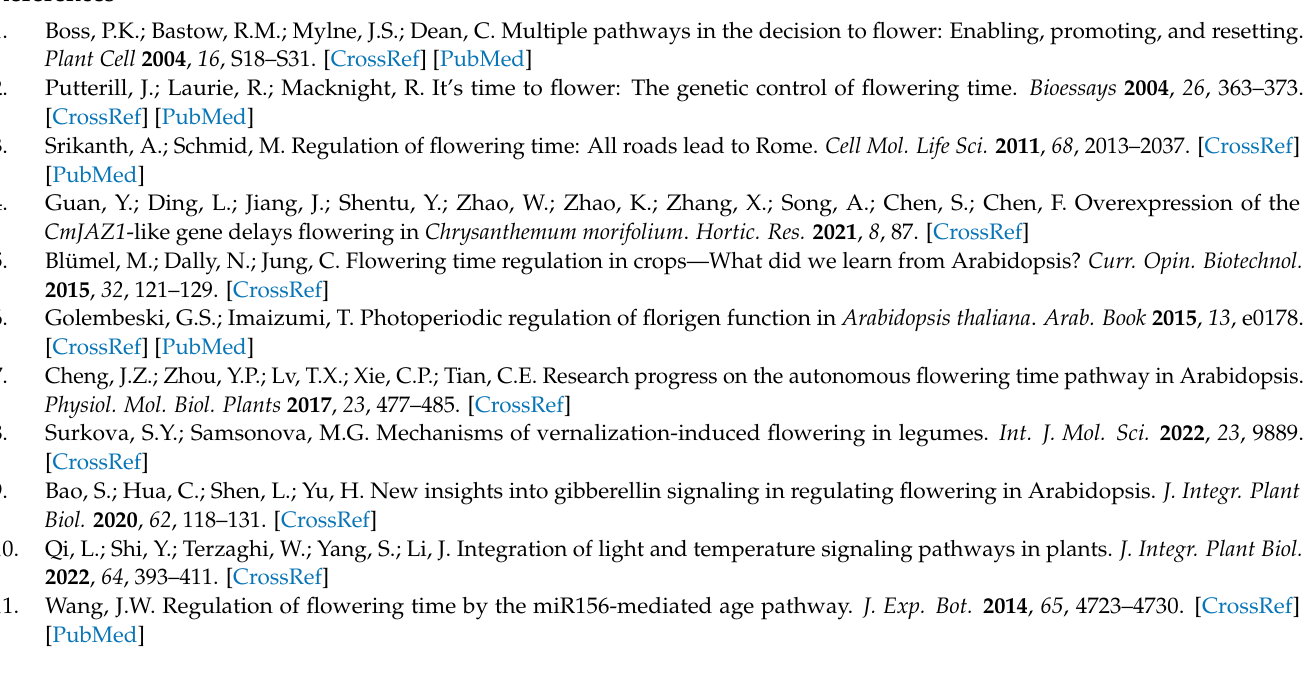
GFP-R. Table S1: Primers used in the present study; Table S2. Statistics for sequencing; Table S3. Statistical comparison of sample sequencing data with the selected reference genomes; Table S4. All of the different expression genes. Table S5. Differentially expressed genes related to flowering time following ethephon